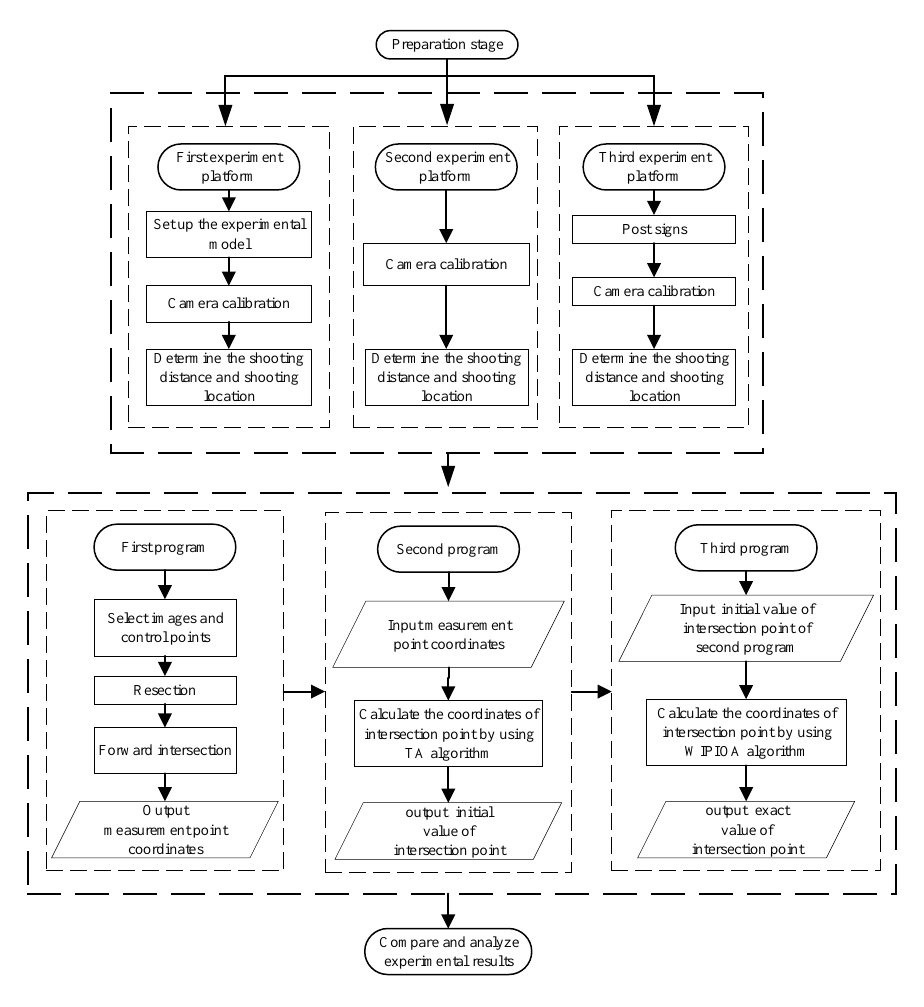
Figure 3. Experimental flow chart. The three sets of photos taken in the experiment are shown in Figures 4–6.